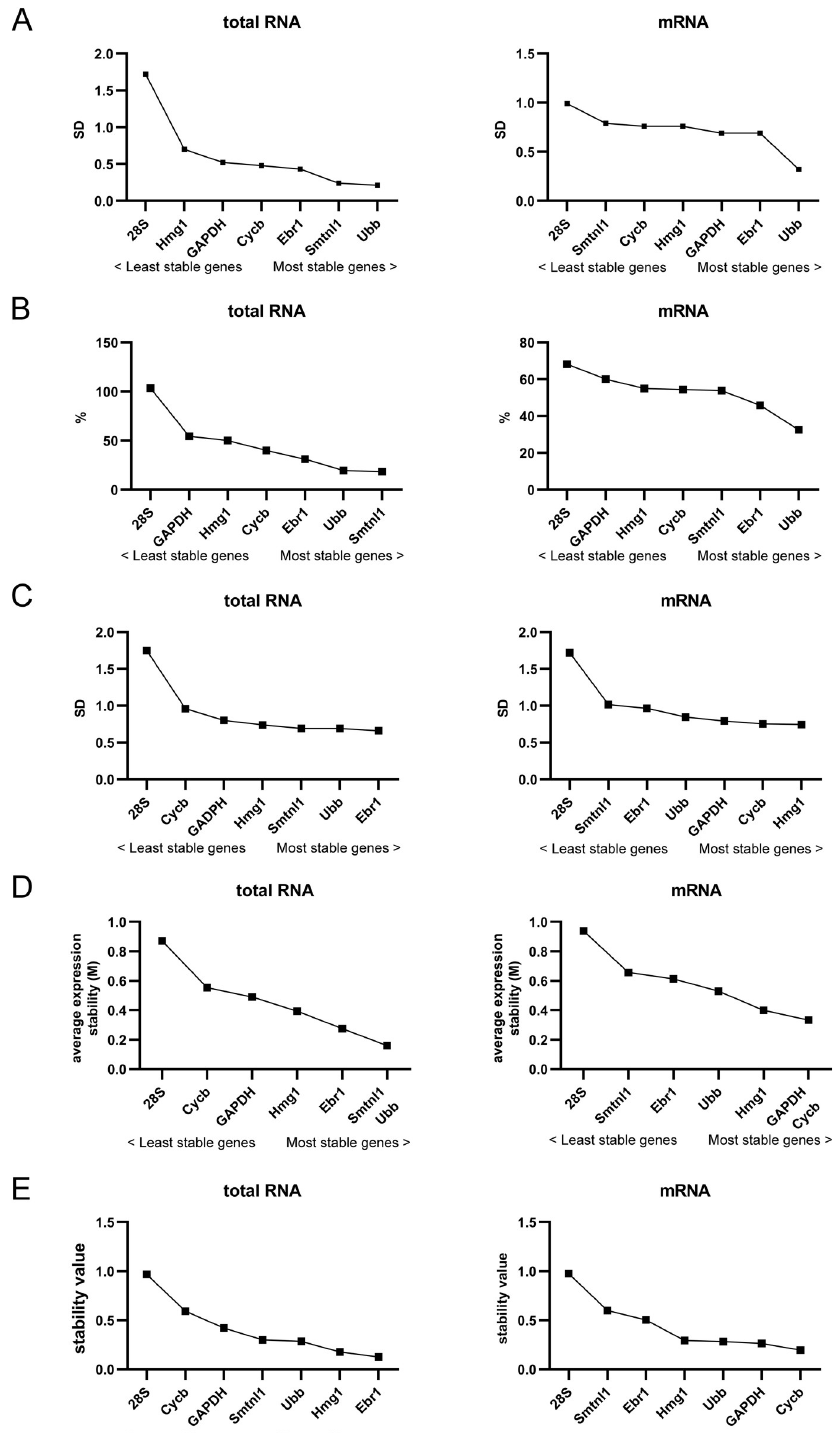
Fig 3. Stability analysis of candidate reference genes performed by different methods. Stability estimated by BestKeeper (A), CV (B) Δ Ct (C), geNorm (D) and NormFinder (E).